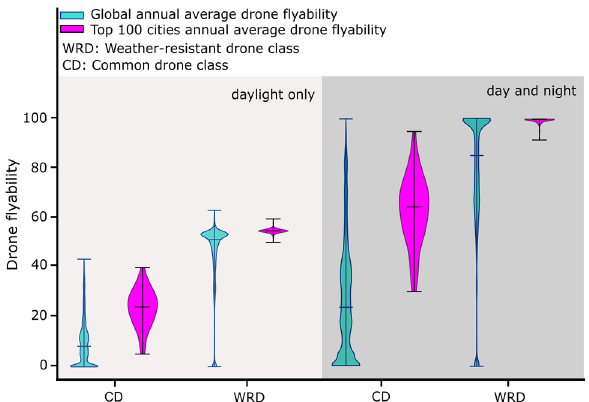
Figure 1. Violin plots of day-and-night and daylight-only flyability for CD and WRD. Cyan violins correspond to the distribution of flyabilities of CD and WRD globally and orange violins represent the distribution of flyabilities of CD and WRD from 100 most populated cities across the world 22 . The upper and lower hinges of violin plots indicate the minimum and maximum flyabilities. The horizontal bar of each violin represents the median of annual average drone